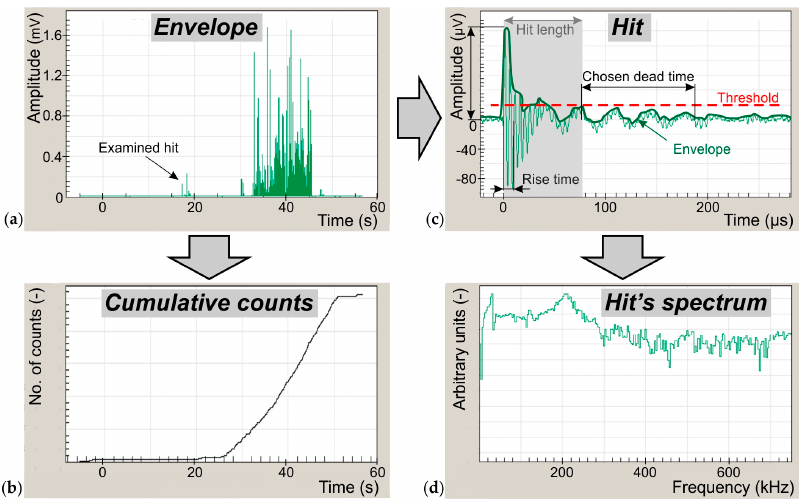
Figure 1. Parameters obtained from an acoustic emission (AE) analysis. ( a ) Compressed signal of complete AE record in form of the Envelope with ( b ) tracked exceedances of chosen amplitude threshold in form of the Cumulative counts . ( c ) Full time resolution AE event called Hit with its threshold described and ( d ) exported Spectrum .